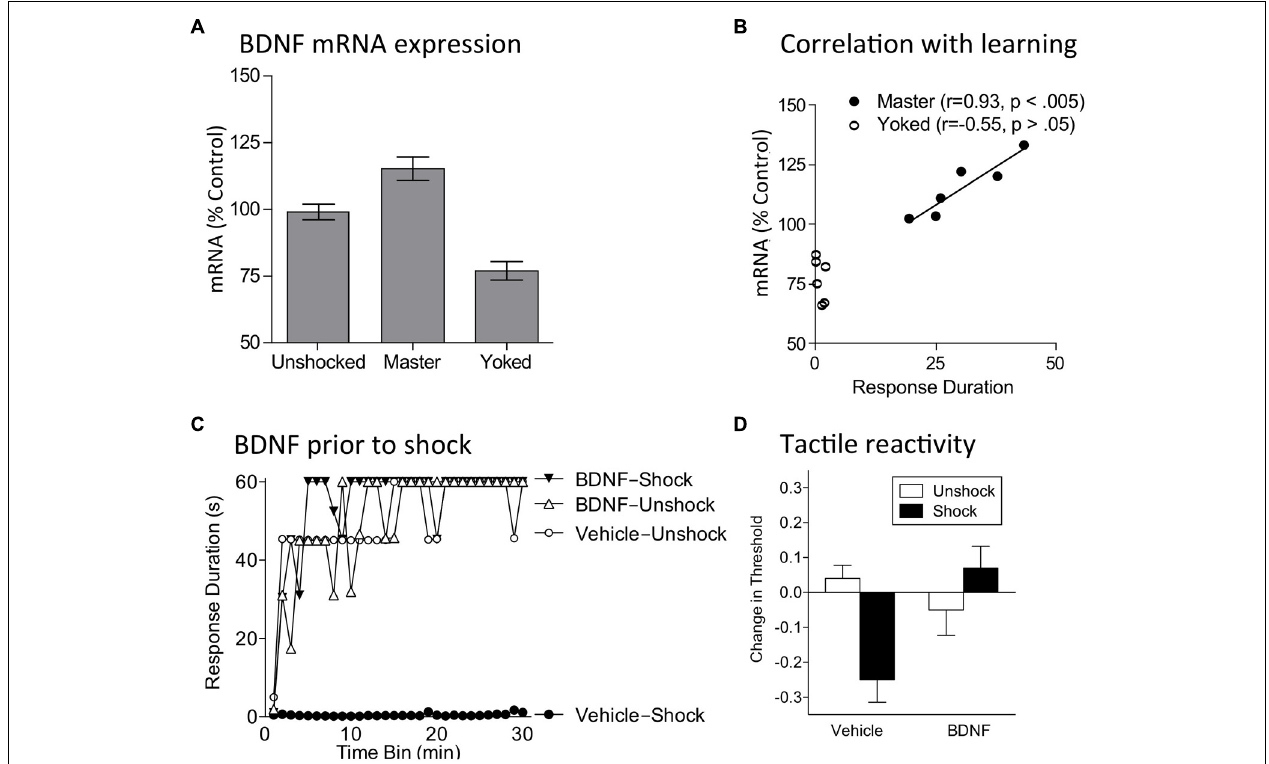
FIGURE 6 | BDNF mediates the beneficial effect of instrumental training. (A) Training with controllable shock (Master) produces an increase in BDNF mRNA expression whereas exposure to uncontrollable shock (Yoked) down-regulates expression. (B) In trained subjects (Master), BDNF mRNA expression is highly correlated with a measure of learning (mean response duration during the first 10 min of training). (C) Subjects were given BDNF (i.t.; 0.4 μ g) or its vehicle and then VIS (Shock) or nothing (Unshock). The next day subjects were tested in the